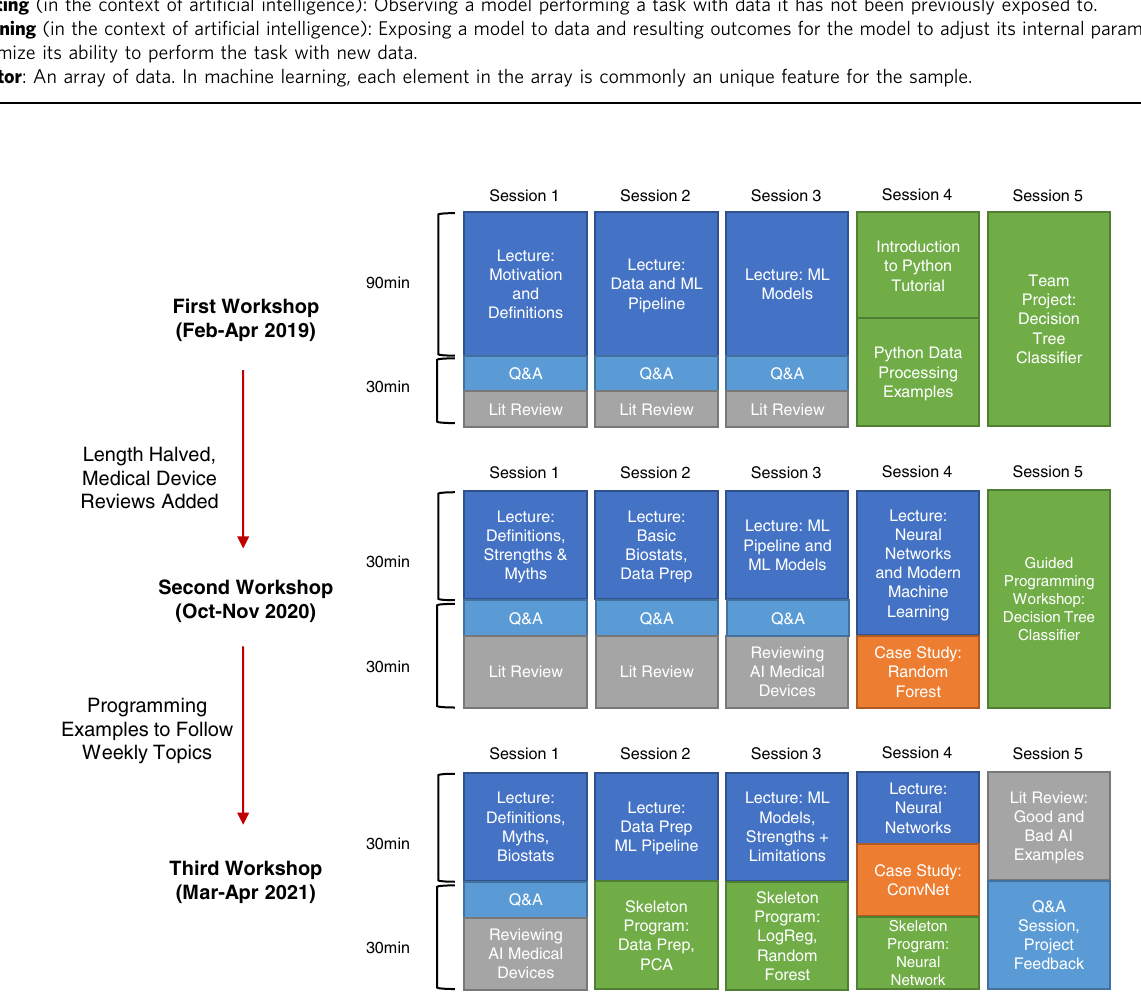
Fig. 1 A visualization of the timeline for the three iterations of our workshop. In blue are lecture topics, with light blue dedicated time for interactive question and answer period. In grey are focused brief literature review sessions. In orange are the selected case studies outlining arti fi cial intelligence models or techniques. In green are the guided programming sessions intended to teach how arti fi cial intelligence can solve clinical problems and how to evaluate the model. The content and length with the workshop changed based on evaluation of student